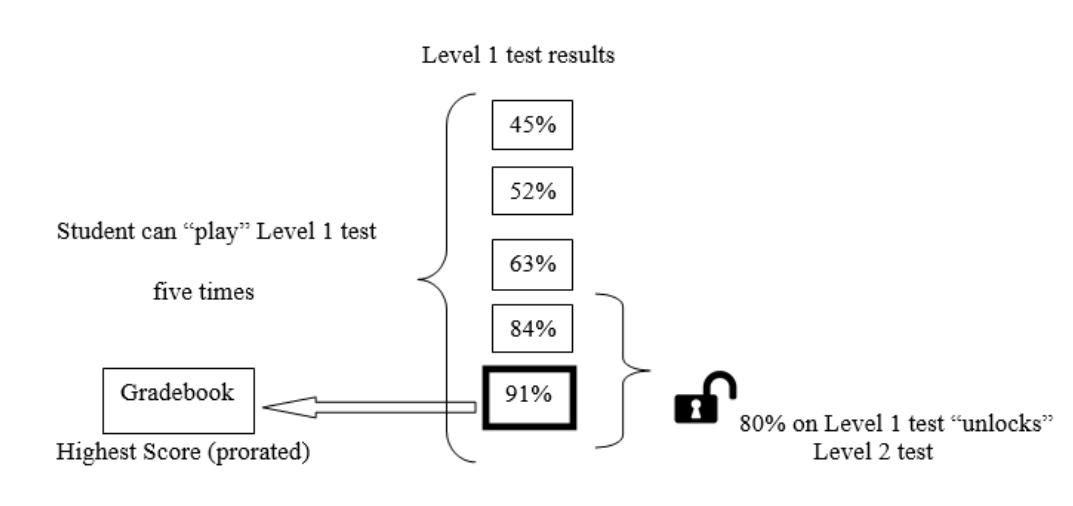
Figure 2. Online test mechanics with applied gamification